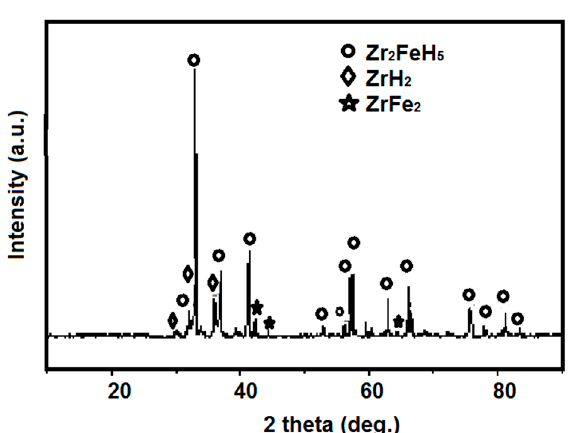
Figure 3. XRD patterns of the hydrogenated product of Zr 2 Fe alloy.